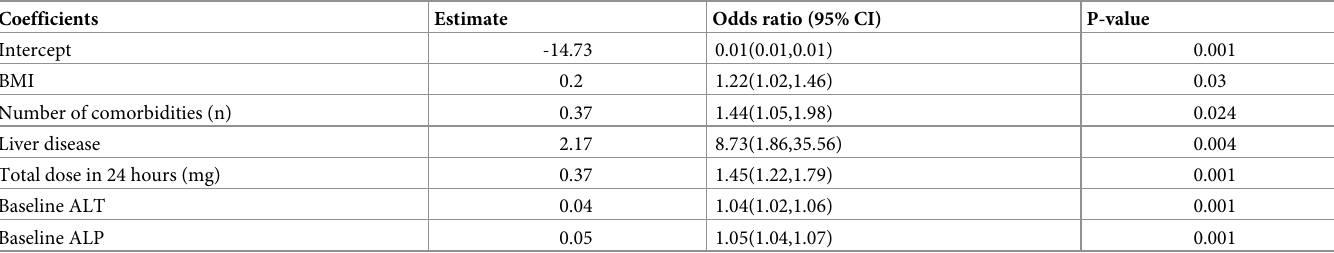
Table 6. Model 3: Multiple logistic-regression results relating the factors of drug-induced liver injury.